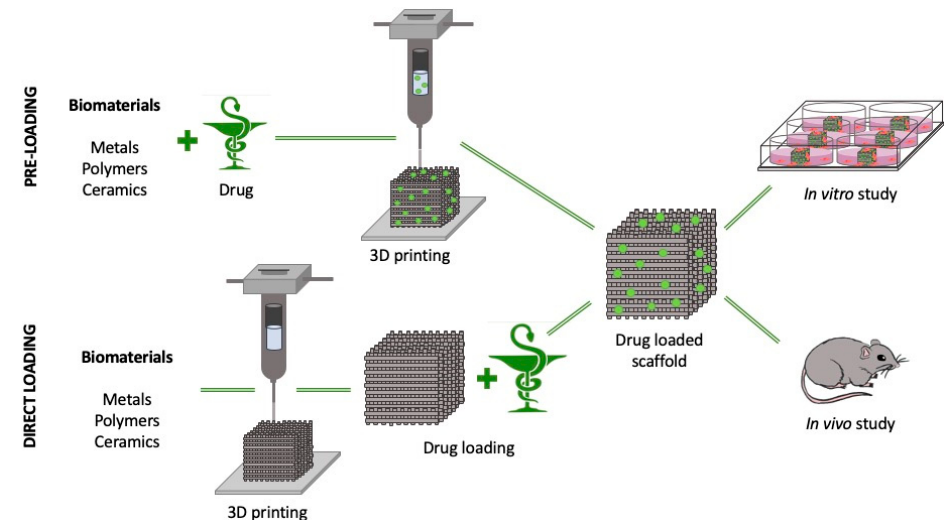
Figure 2. Schematic layout summarizing pre-loading and direct loading 3DP porous substrate fabrication for in vitro and in vivo drug delivery applications.